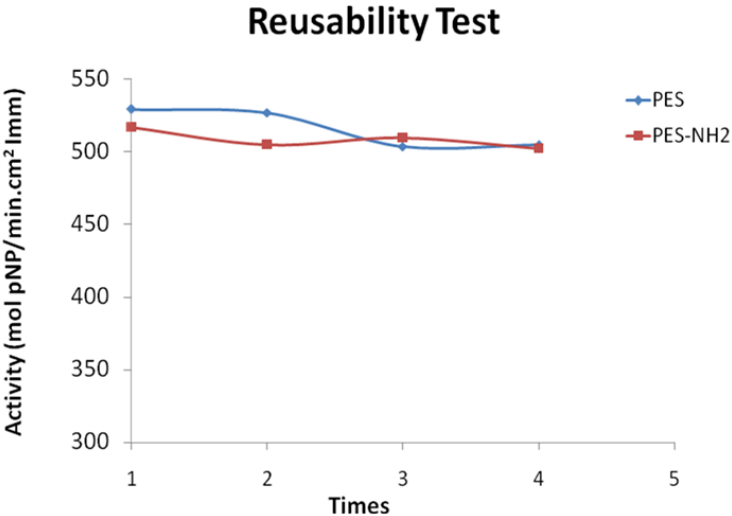
Figure 6. Profile of reusability test for immobilized enzyme on both PES and PES–NH membranes (repeated four